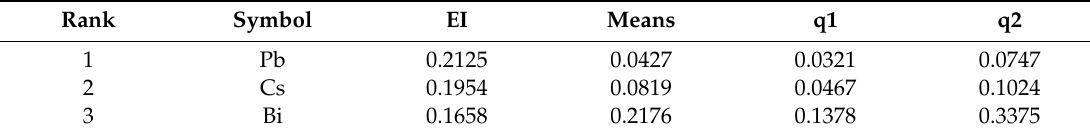
Table 5. Prediction by the first regression model for further screening.